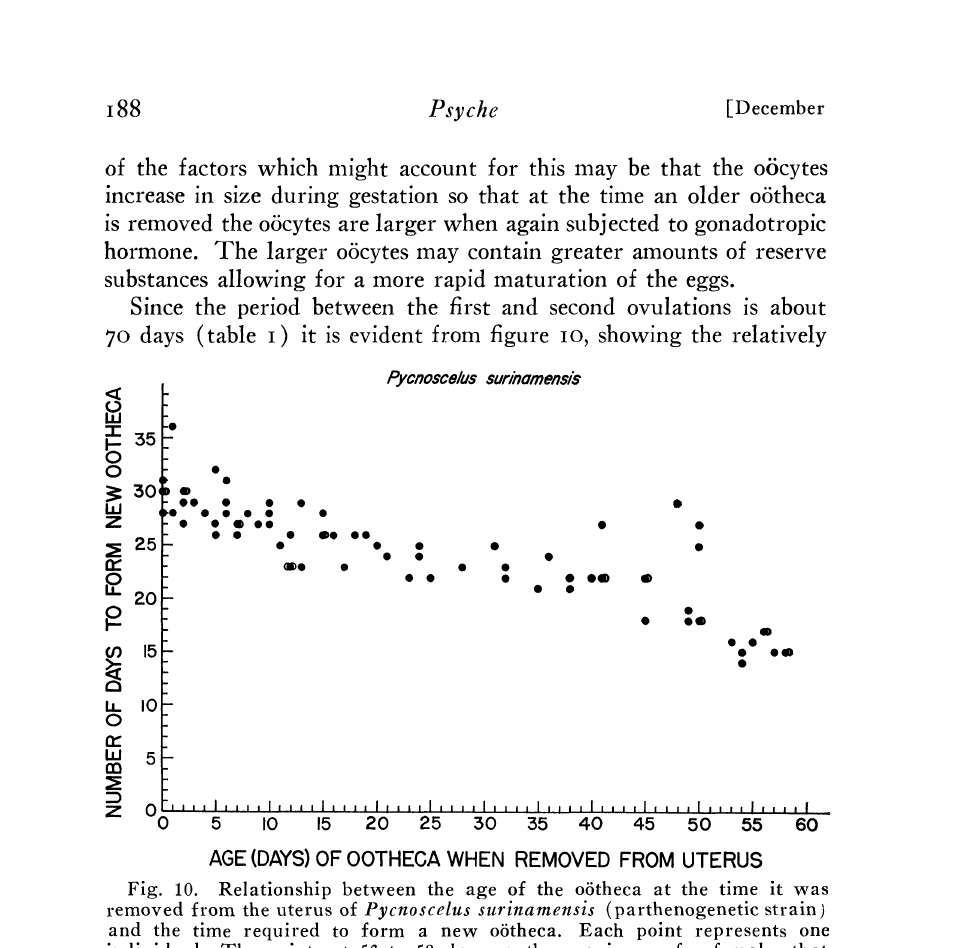
Fig. 10. Relationship between the age of the o6theca at the time it was removed from the uterus of Pycnoscelus surinamensis (parthenogenetic strain) and the time required to form a new o6theca. Each point represents one individual. The points at 53 to 58 days on the x axis, are for females that gave birth normally; all of the other points are based on females that had their o6thecae removed manually. rapid development of the o6cytes (as indicated by oviposition) after removal of the o6theca, that the o6cytes are inhibited by the presence of the eggs in the